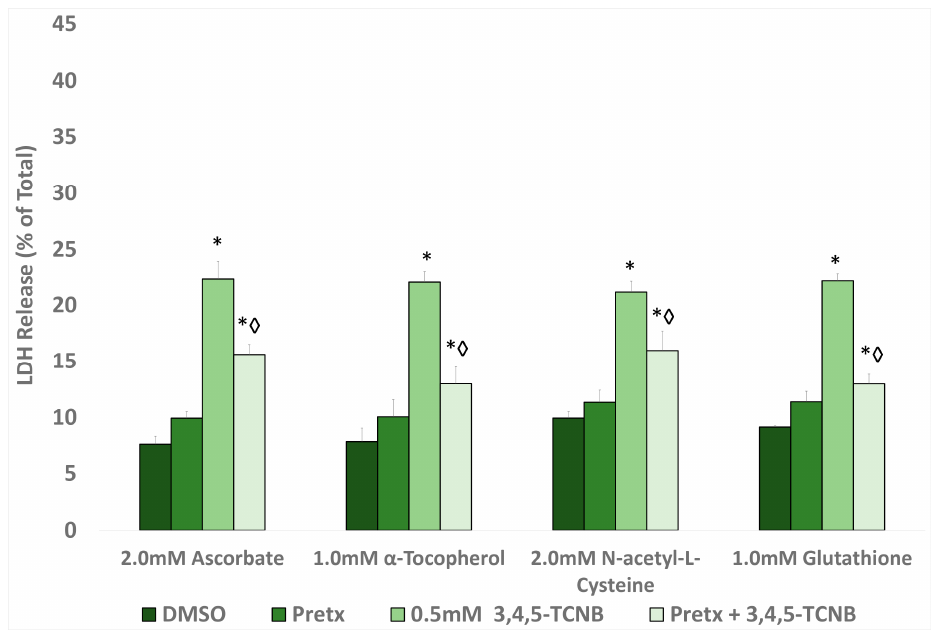
Figure 3. Effect of antioxidant pretreatment on 3,4,5-TCNB 0.5 mM cytotoxicity after a 30 min 3,4,5- TCNB incubation period. An * indicates significant difference from the DMSO control value, p < 0.05. A diamond indicates significant difference from the 3,4,5-TCNB group only value, p < 0.05. n = 4.